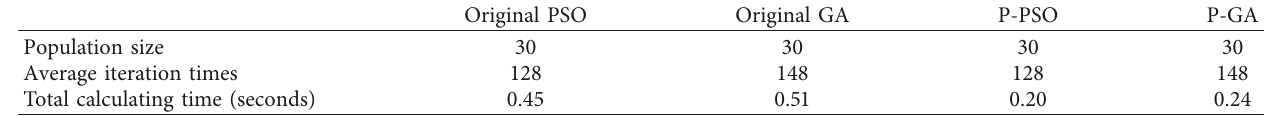
Table 5: Comparison of calculating time of original GA, PSO, and their application of parallel computing.